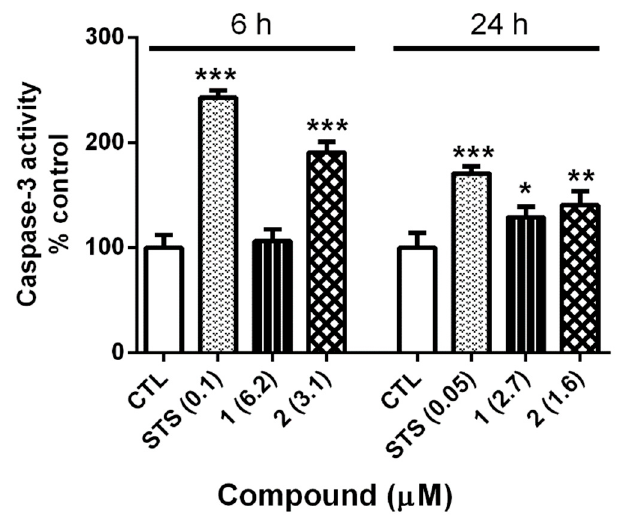
Figure 5. Caspase-3 activity in human neuroblastoma cells treated with gold compounds 1 and 2 . Compounds were added to the cells for 6 h and 24 h. STS was used as a positive control. Data are mean ± SEM of three experiments performed in triplicate, expressed as a percentage of control cells, and compared control cells by Student’s t test. * p < 0.05, ** p < 0.01, *** p < 0.001.